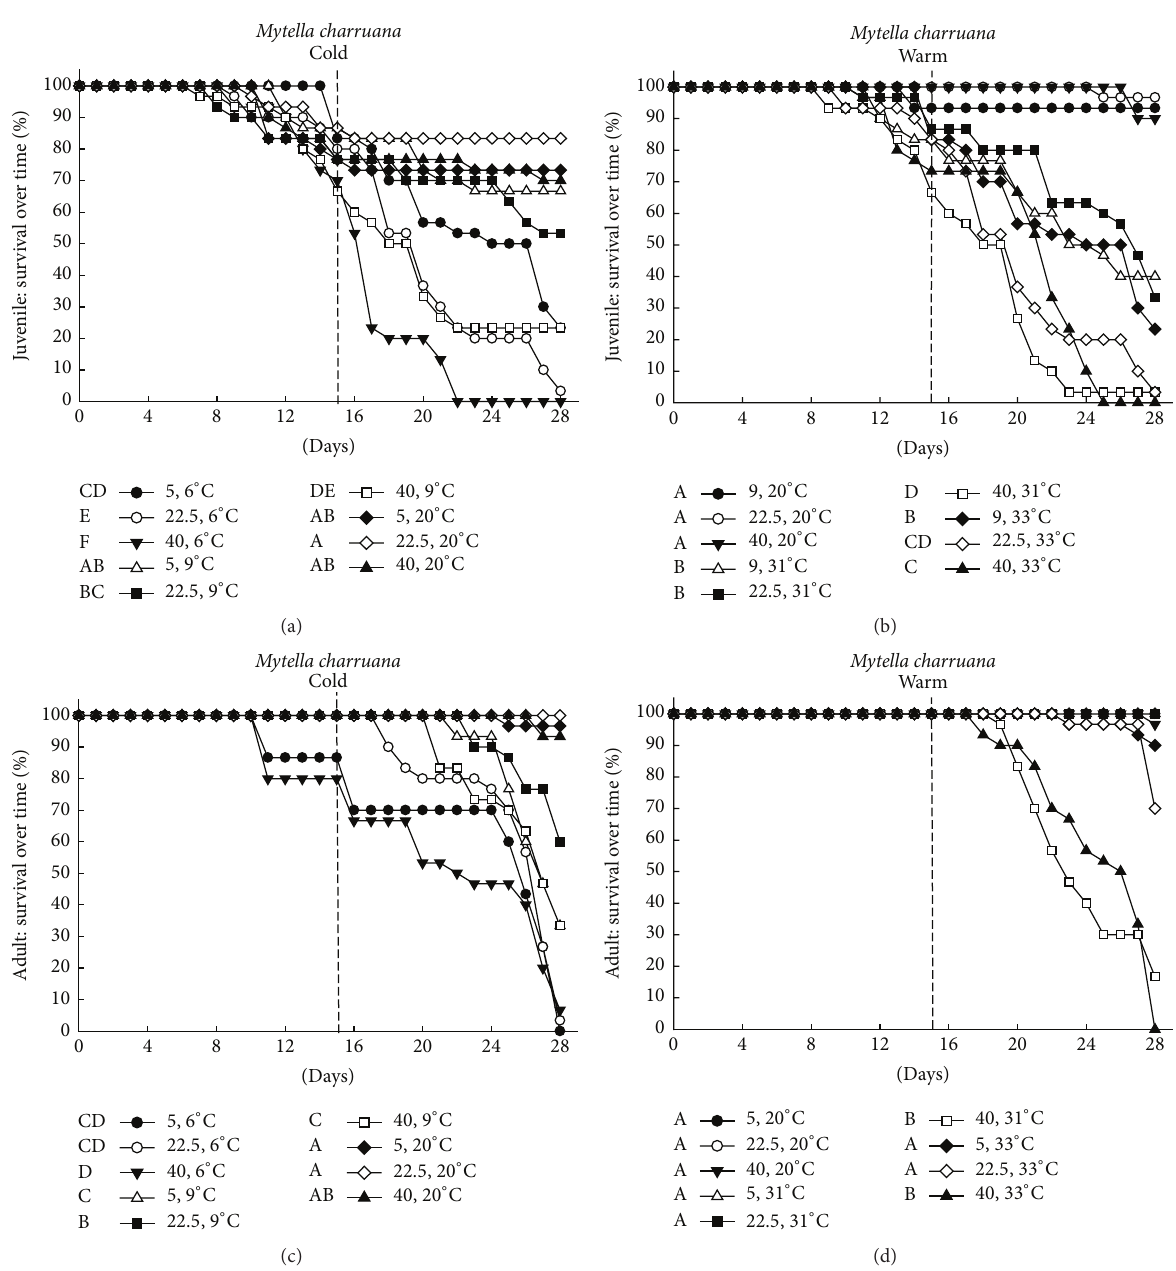
Figure 5: Survivorship curves over 28 days for Mytella charruana in the salinity-temperature interaction experiments. (a) Juvenile, cold experiment (temperatures: 6, 9, and 20 ∘ C; salinities: 5, 22.5, and 40 ppt), (b) juvenile, warm experiment (temperatures: 20, 31, and 33 ∘ C; salinities: 9, 22.5, and 40ppt), (c) adult, cold experiment (temperatures: 6, 9, and 20 ∘ C; salinities: 5, 22.5, and 40 ppt), and (d) adult, warm experiment (temperatures: 20, 31, and 33 ∘ C; salinities: 5, 22.5, and 40ppt). Upper case letters indicate significant differences of 𝑝 ≤ 0.05 among treatments using survival analysis. Dotted lines show the end of the 15-day temperature adjustment